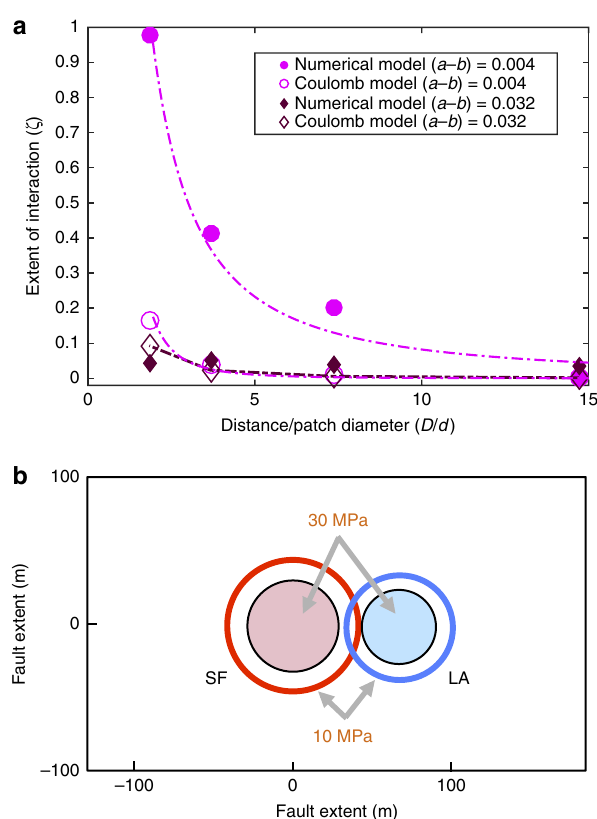
Figure 4 | Effect of the VS region on the interaction. ( a ) Comparison of interaction with different friction properties of the VS region: ( a (cid:2) b ) VS ¼ 0.004 (circles) and 0.032 (diamonds). Filled and empty markers represent our numerical model and Coulomb model, respectively. Postseismic creep (and its effect) is suppressed as ( a (cid:2) b ) VS increases from 0.004 to 0.032. ( b ) Schematic diagram of the relative location of the SF and LA repeaters based on the study of Zoback et al. 17 . The extent of the patches for both 10MPa (empty circles) and 30MPa (filled circles) stress drops are shown; D / d changes with different stress drop estimates. For the stress drops of 30MPa, the repeaters are separated by about 1.4 average patch diameters; the nearly instantaneous triggering observed for these repeaters before 2004 is consistent with our findings and can be used to constrain the VS properties of the creeping